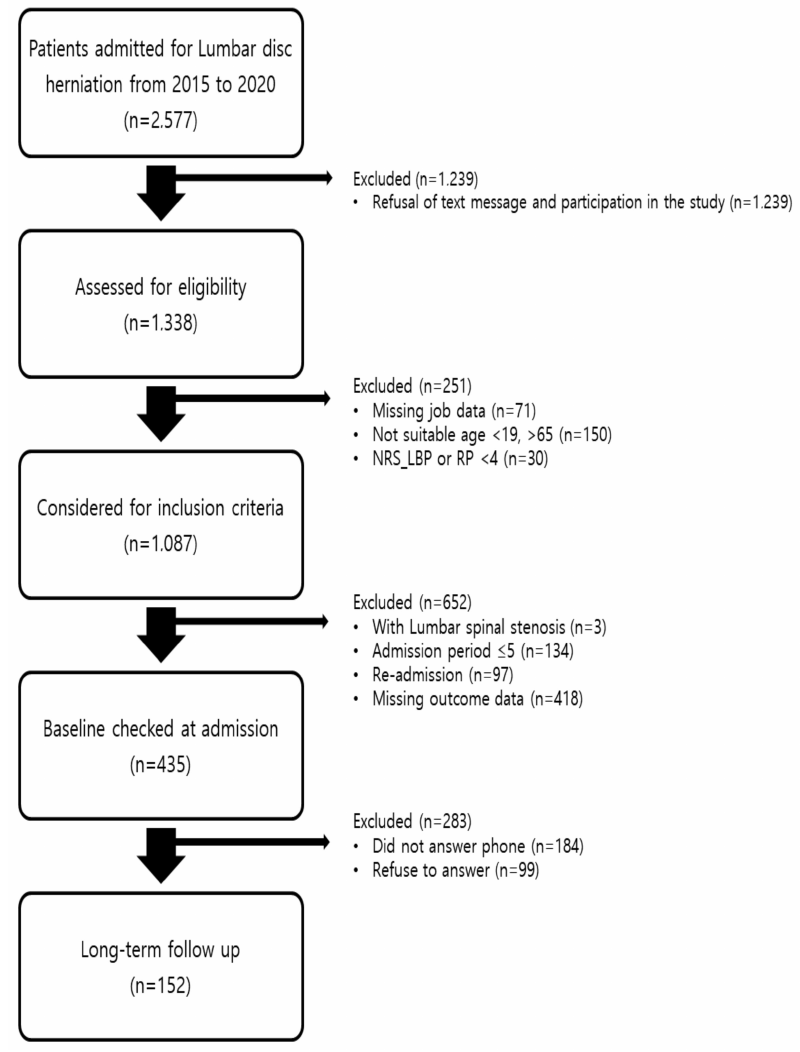
Figure 1. Flow chart. Abbreviations: Numerical Rating Scale (NRS); LBP, Low back pain (LBP); radiating leg pain